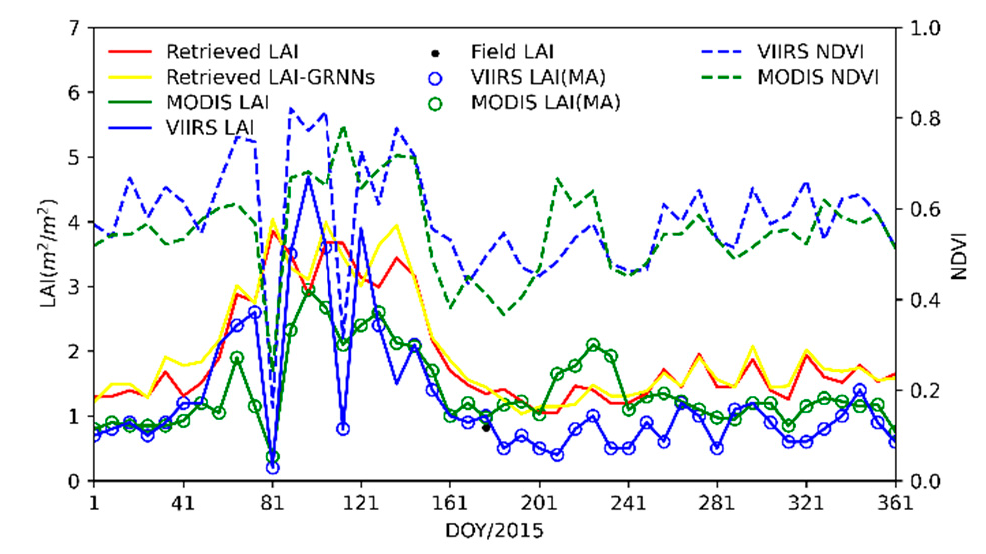
Figure 9. Temporal trajectories of the LAI-TCA and the LAI-GRNN at the center pixel of the Peyrousse site for 2015.